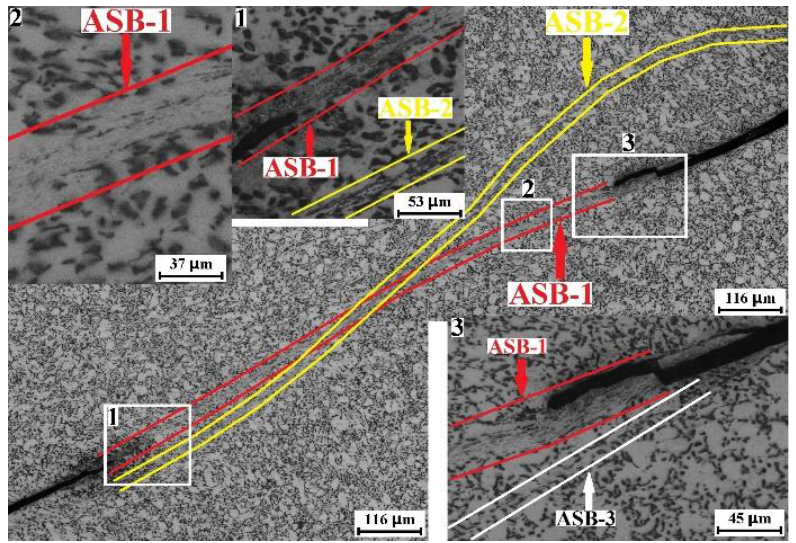
Figure 8. Optical micrographs regarding the adiabatic shearing behavior of mill-annealed Ti-6Al-4V alloy plate compressed in the RD. The loading direction is vertical. Insertion 1, insertion 2 and insertion 3 are the high-magnification optical micrographs for the rectangle region 1, rectangle region 2 and rectangle region 3.